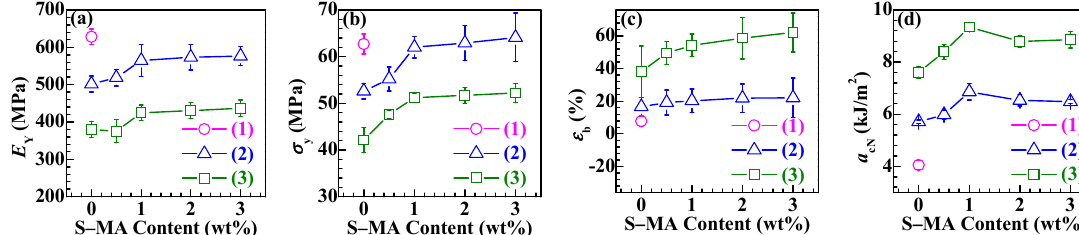
Figure 7. ( a )–( c ) Tensile properties, i.e., ( a ) Young’s moduli ( E Y ), ( b ) tensile strength ( σ y ), and ( c ) elongation at break ( ε b ), and ( d ) Charpy notched impact strength ( a cN ) for (1) (neat) PLA, (2) blends of PLA and SBS triblock copolymer (95/5 w/w) compatibilized with different amounts (0, 0.5, 1.0, 2.0, and 3.0 wt %) of S-MA), and (3) blends of PLA and SBS (90/10 w/w) compatibilized with different amounts of S-MA.